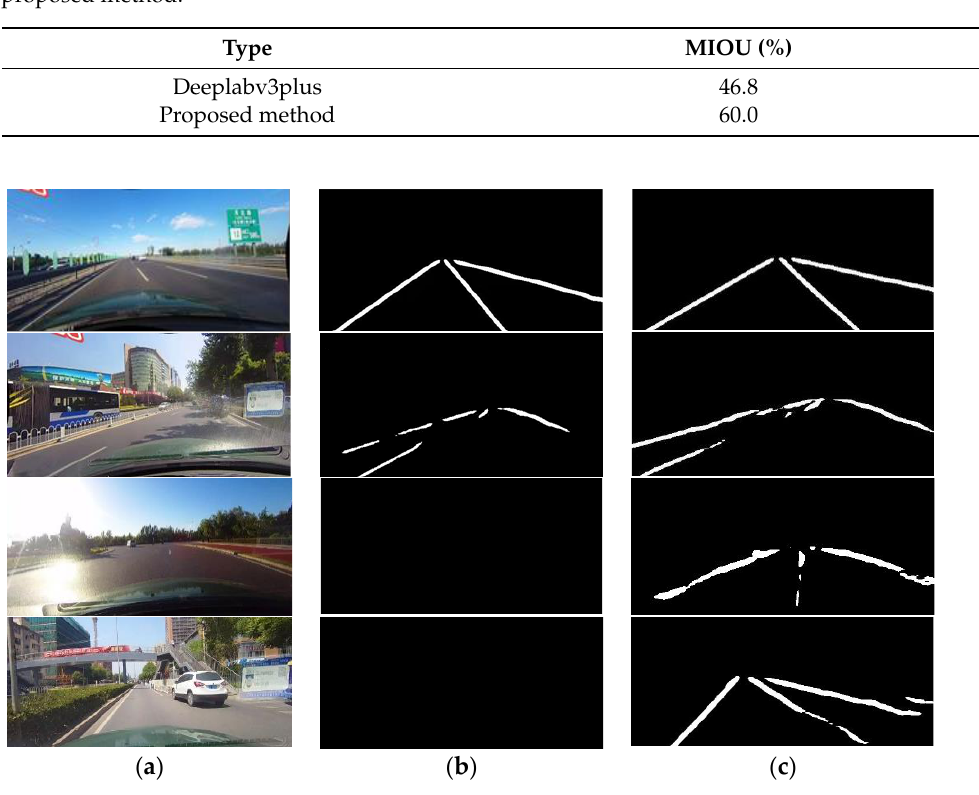
Figure 6. The original input image and the recognition result. ( a ) input image; ( b ) deeplabv3plus with RESNET18; ( c ) the proposed